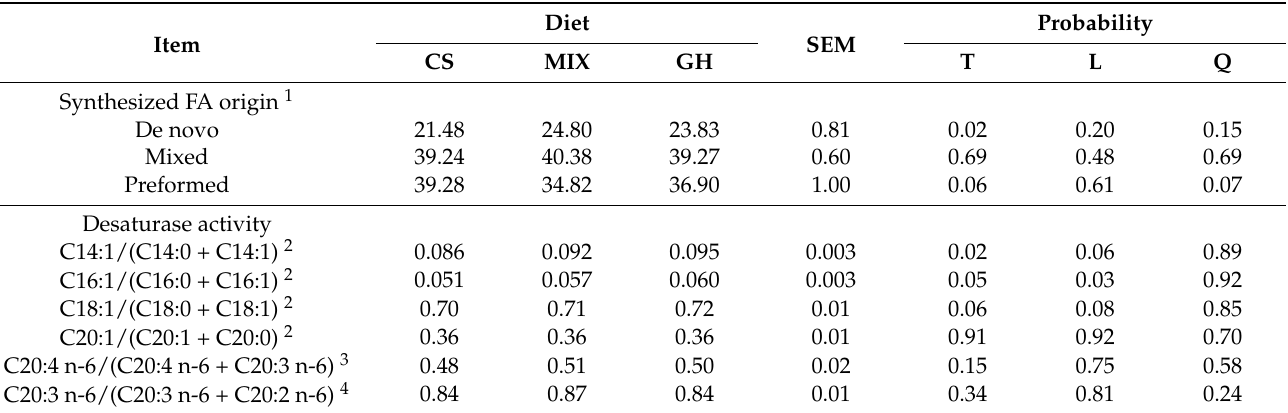
Table 7. Effects of different dietary forage sources on synthesized fatty acid origins (% of total fatty acids) and desaturase activity in milk of